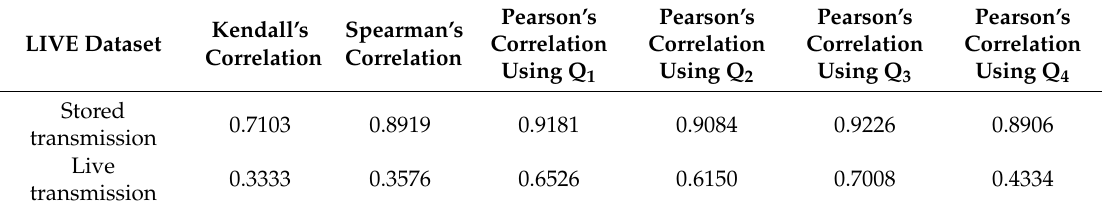
Table 6. Kendall’s, Spearman’s, and Pearson’s correlation, using LIVE mobile, stored transmission video sequences, and LIVE mobile live transmission video